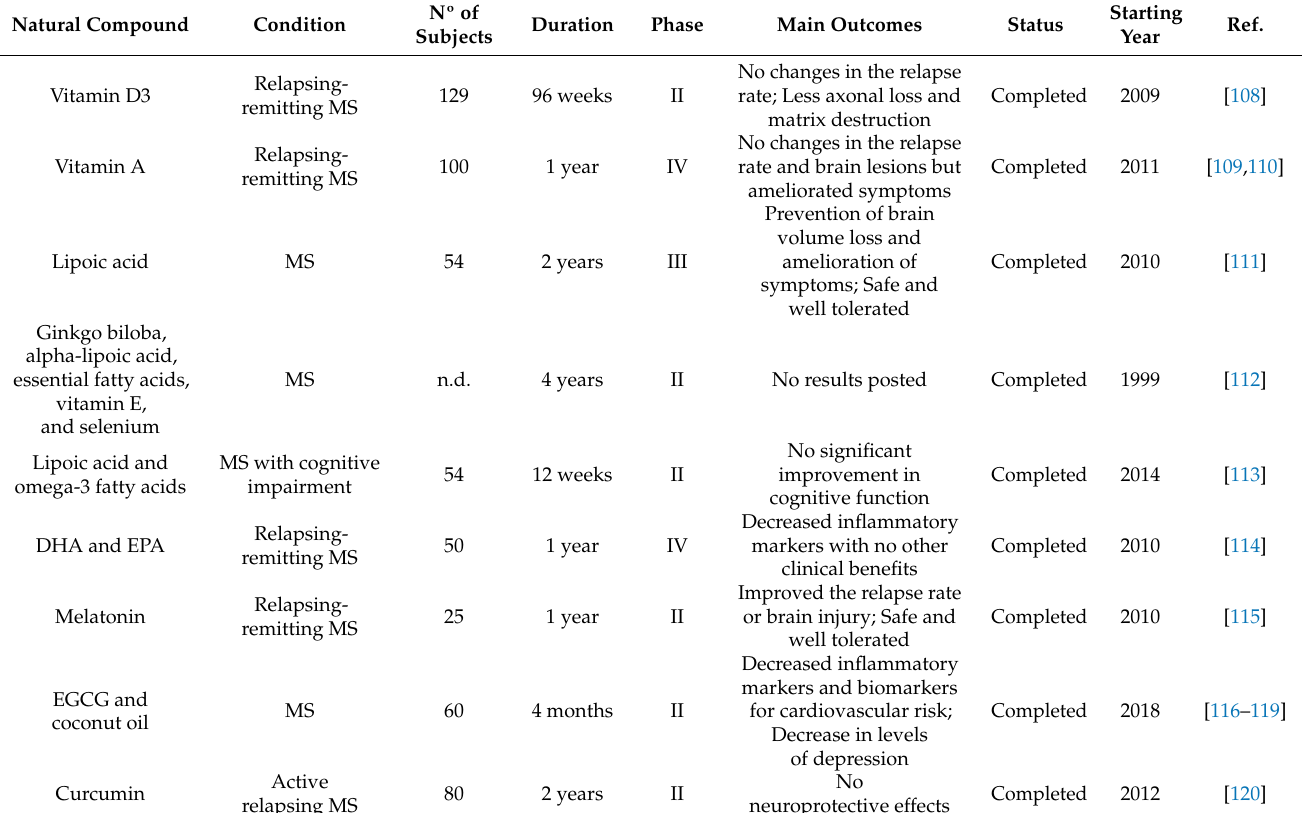
Table 3. Natural compounds in clinical trials for MS